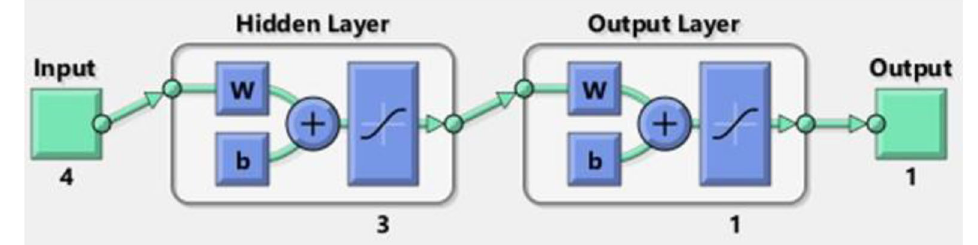
Fig. 1 Adopted ANN architecture for predicting the elemental composition